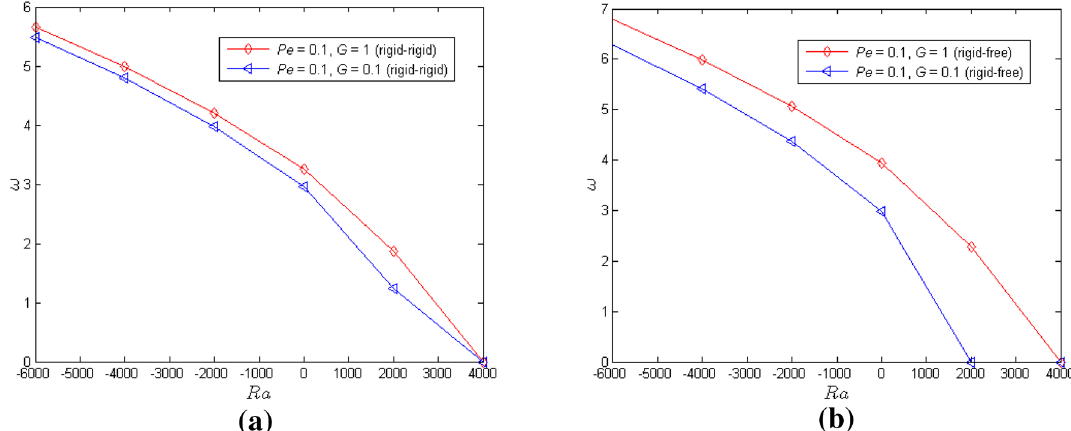
Fig. 9 The case of rigid–rigid and rigid–free walls: a , b Boundaries of oscillatory mode of instability in the ( Ra , 𝜔 ) plane for the various values of gyrotactic number G and Péclet number